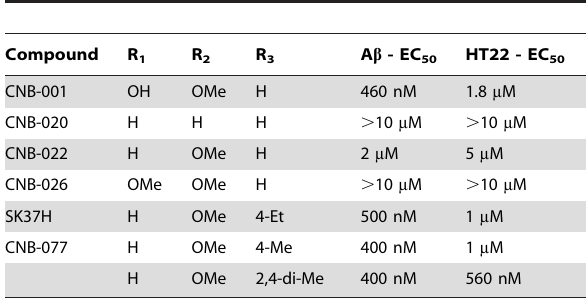
Table 1. Structure activity relationship of a few CNB-001 derivatives.